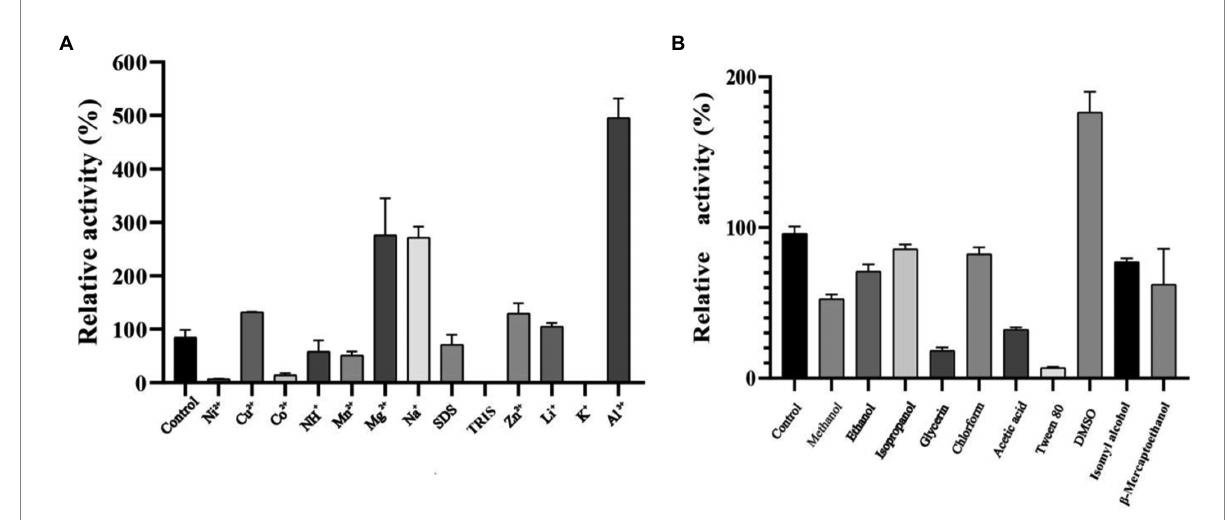
FIGURE 6 (A) Effects of metal ions and chemical reagents on the activity of RpfB recombinant protein. (B) Effect of organic solvents on RpfB activity. Untreated enzyme was used as the control and defined as 100% relative